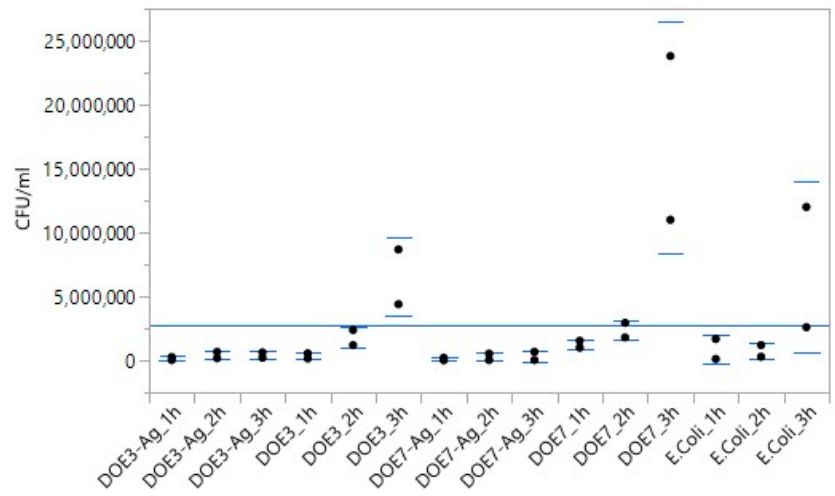
Figure 13. Plot of mean value of each treatment vs. grand mean of all pooled data. Following method 2 described in Section 2.9, the bacterial population normalized with respect to the E. coli control culture is reported in Figure 14 (left panel), where the inhibitory effect in the coated samples is evident in comparison with the microbial growth on the uncoated PSU samples. The antimicrobial effect of the Ag nanocoating is more clear when calculating the residual bacterial population on the Ag-coated samples as a percentage with respect to the corresponding uncoated substrates, as demonstrated in Figure 14 (right panel).